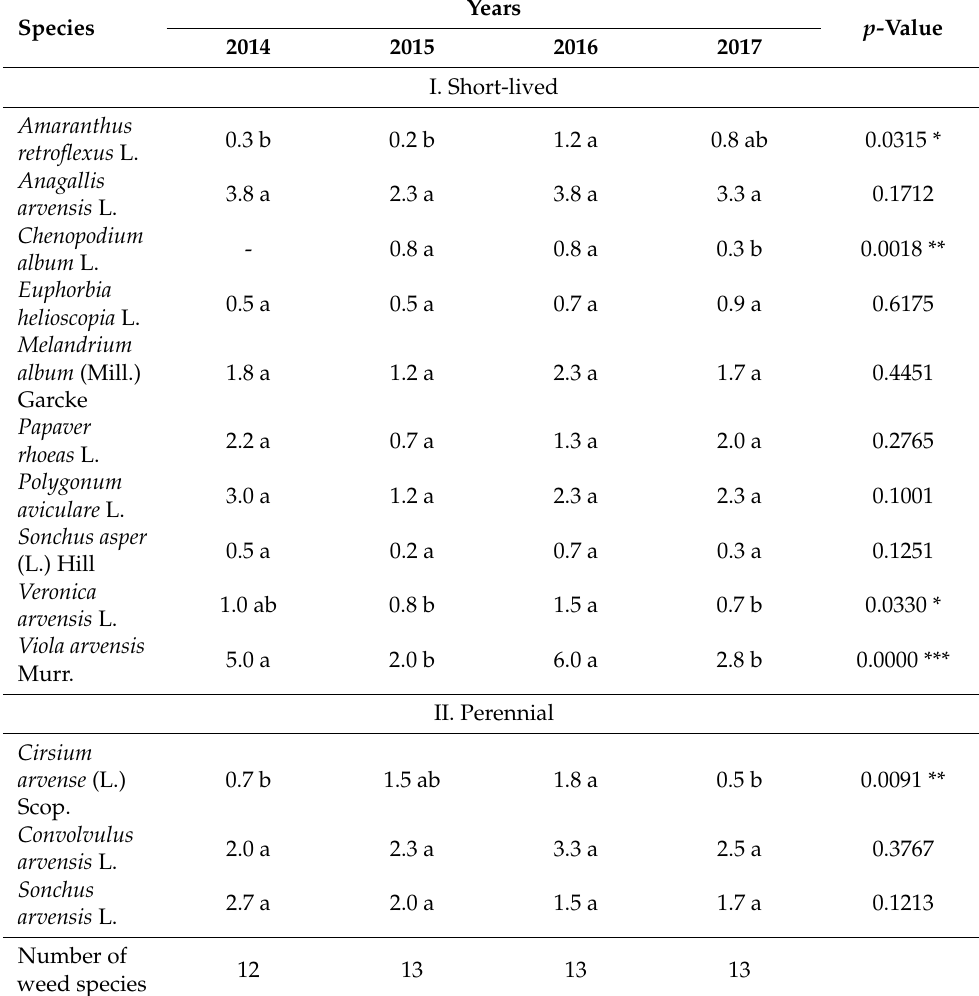
Table 9. Species composition of weeds per 1 m 2 in winter oilseed rape crop depending on years of